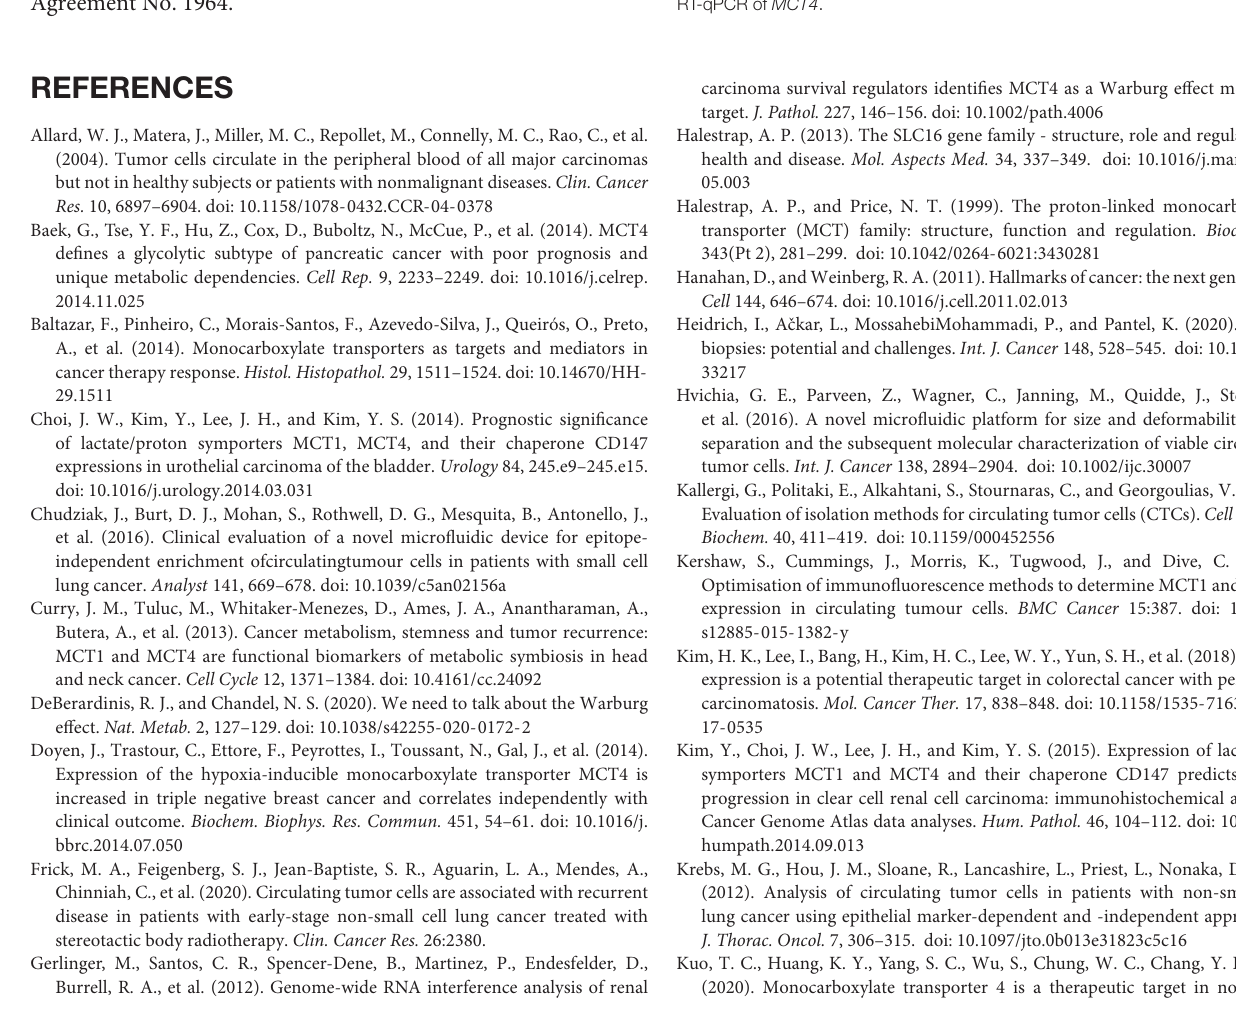
Supplementary Figure 1 | Positive and negative controls of CK/A45/VIM staining. (A) Cytospin with H1299 cells stained with CK/A45 (green) anti-mouse, Alexa 488 anti-mouse, VIM (red) anti-rabbit and Alexa 555 anti-rabbit (positive control). (B) Cytospin with H1299 cells stained with Alexa 488 anti-mouse, VIM (red) anti-rabbit and Alexa 555 anti-rabbit (negative control for CK). (C) Cytospin with H1299 cells stained with CK/A45 (green) anti-mouse, Alexa 488 anti-mouse and Alexa 555 anti-rabbit (negative control for VIM). Supplementary Figure 2 | Phenotypic characterization of CK low /CK − CTCs. Patients’ samples were stained with DAPI (blue; first column), CK/A45 (green; second column) and VIM (red; third column). The fourth column shows overlays. Representative images from confocal laser scanning microscopy of (A) CK low /CK − /VIM − and (B) CK low /CK − /VIM + CTCs. Scale bars = 10 µ m. Supplementary Table 1 | Patients clinicopathological characteristics.